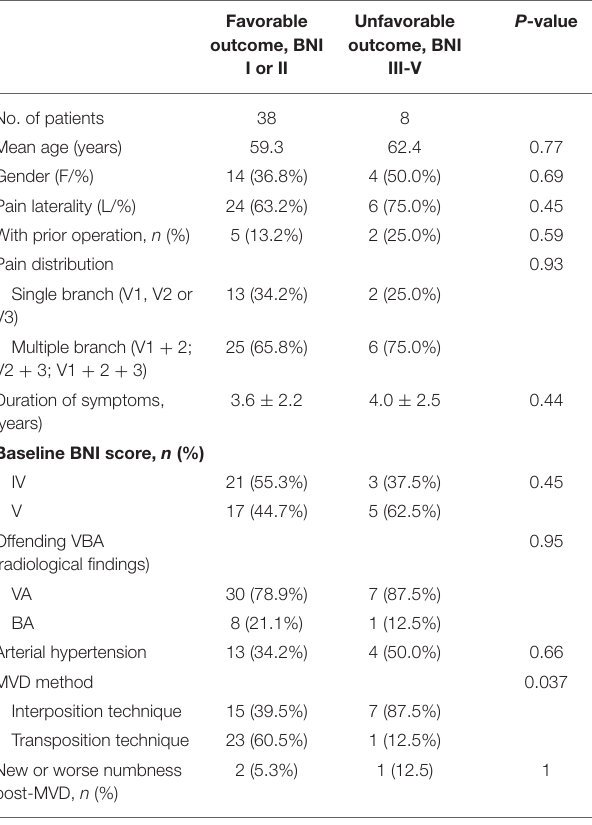
Favorable outcome,